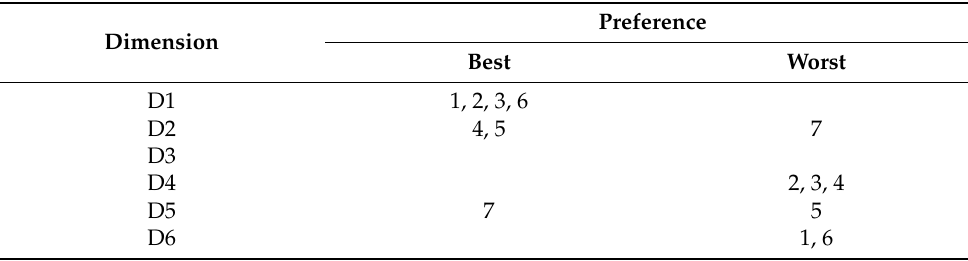
Preference Best Worst